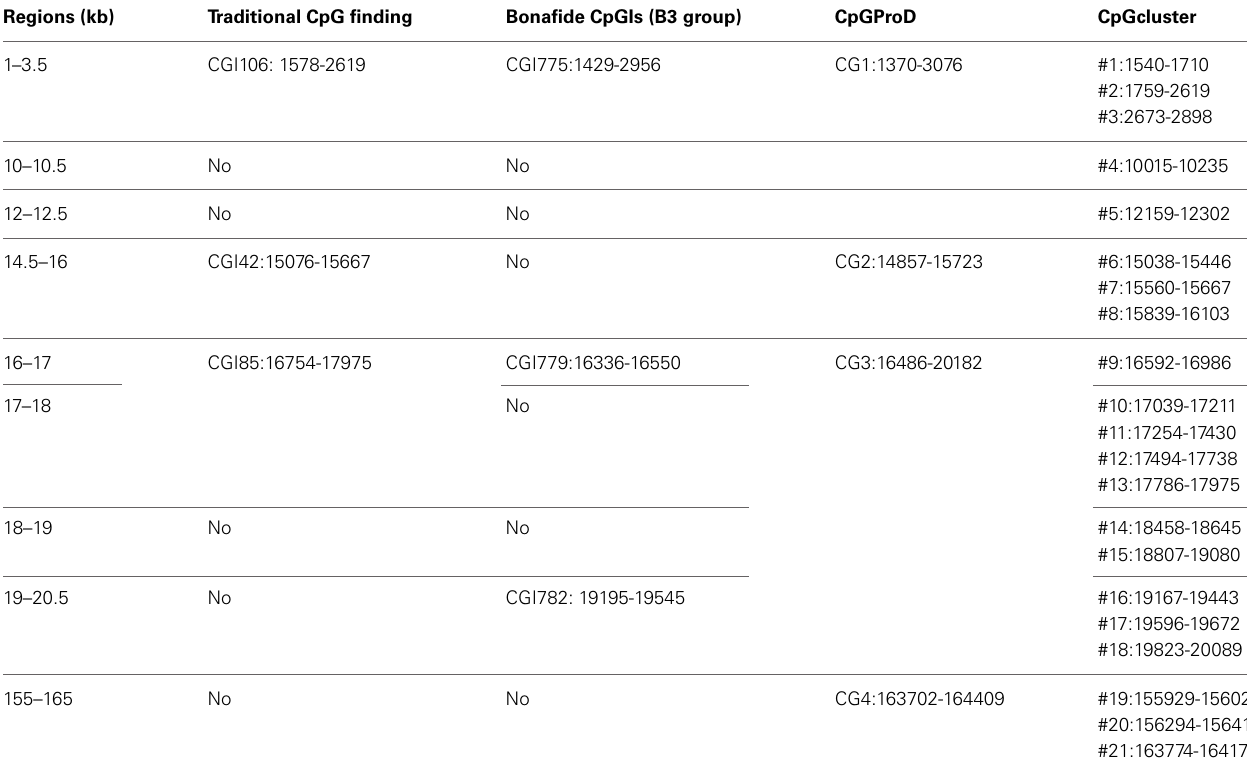
Table 3 | Comparison of CpGs identified with different programs. Regions (kb)